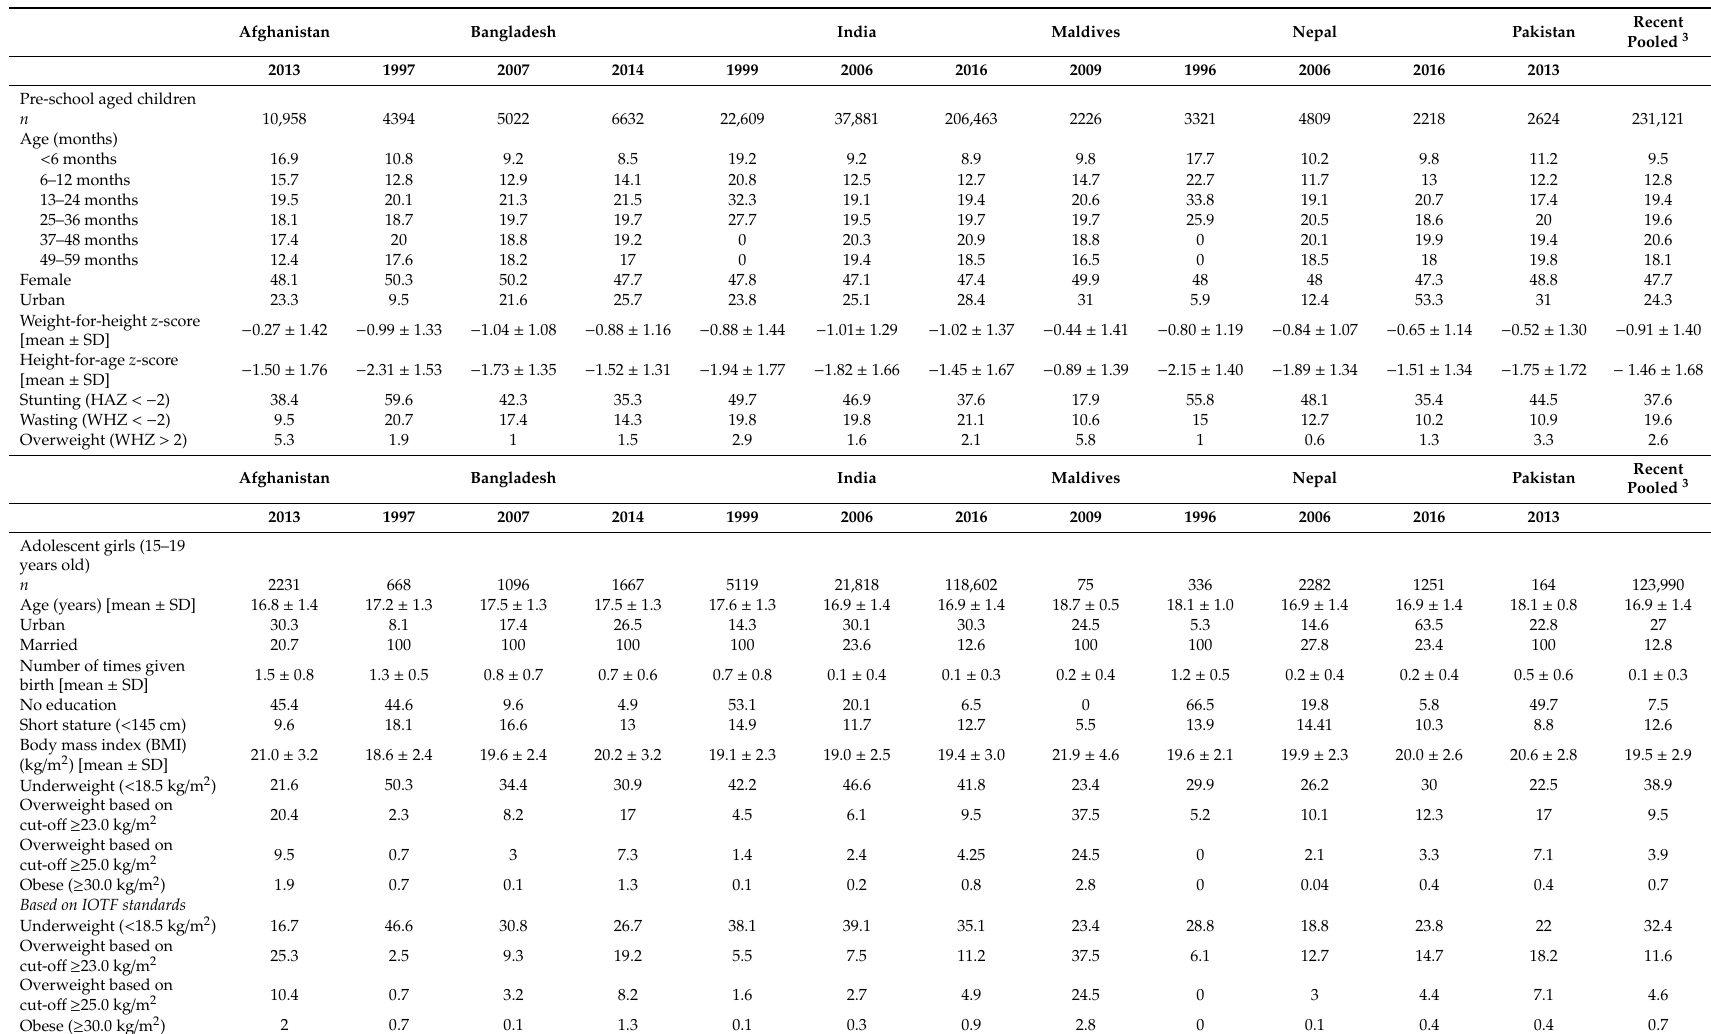
Table 1. Descriptive statistics of the study population 1,2